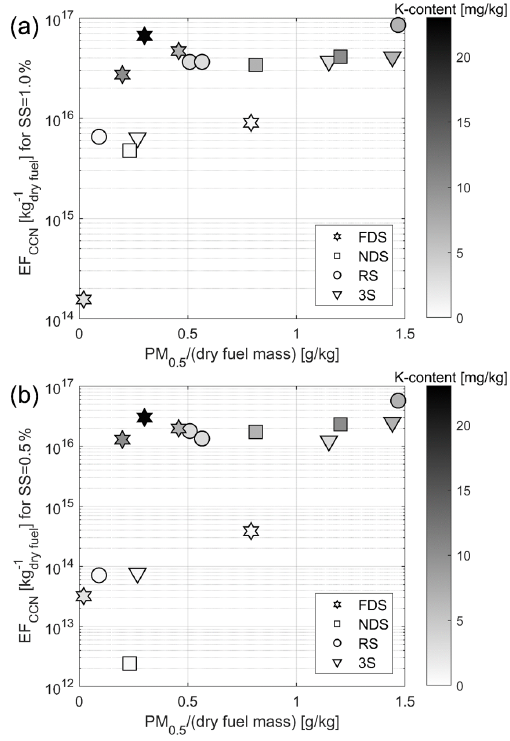
Figure 7. Primary emission factors (EFs) of cloud condensation nuclei (CCN) normalised to dry fuel consumption for a supersat- uration (SS) of 1.0% in (a) and 0.5% in (b) , respectively, versus estimated EFs of PM 0 . 5 . The colour bar indicates the potassium concentration in the dry fuel. The CCN EFs are presented for a larger range of SS in Fig. 5, and more details about the inorganic composition of the fuels can be found in Table 3. The EFs of PM 0 . 5 are estimated from the particle number size distributions shown in Fig. 2 in conjunction with effective density measurements as pre- sented in Fig. 4. It should be noted that the range of the ordinate differs between the two